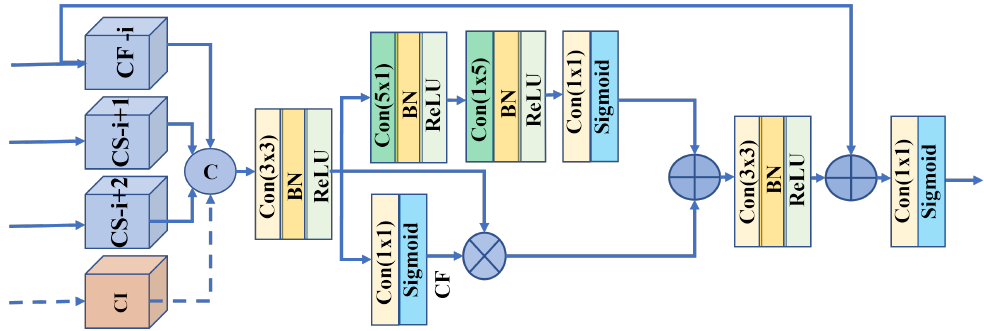
Figure 5. Contour-aware saliency refinement unit (CSRU), in which the supervised contour features (CFs) are integrated with salient features maps to guide the model towards more precise saliency maps with sharp edges. “CF − i” and “CS − i” indicate CFIU and CSRU modules,